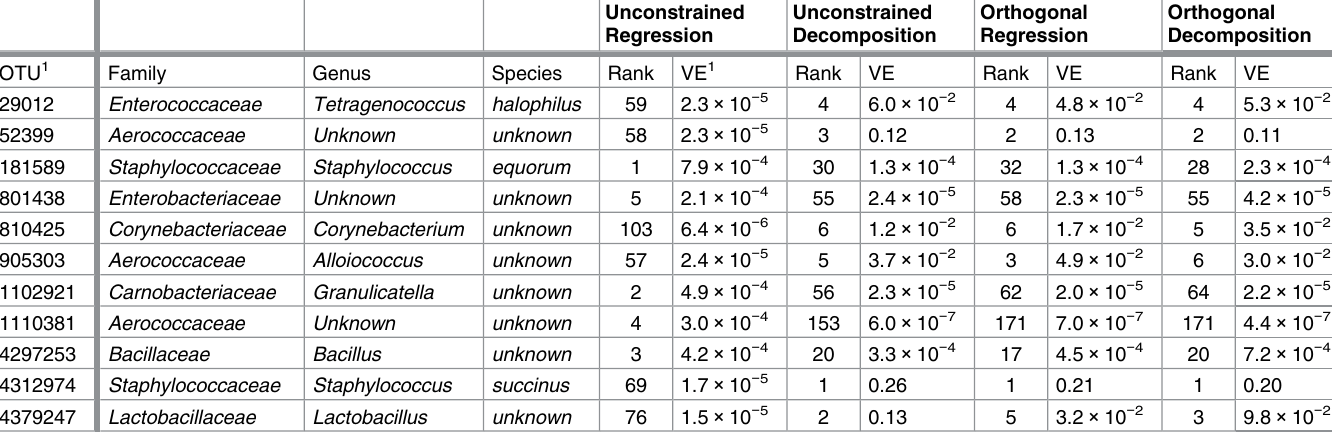
Table 3. Taxonomic assignment for OTUs selected as a top 5 OTU in explaining variability, and the variability explained by each OTU ( d = 3